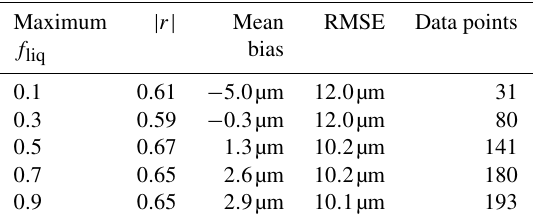
Table C2. Determination of r ice depending on the cloud phase.